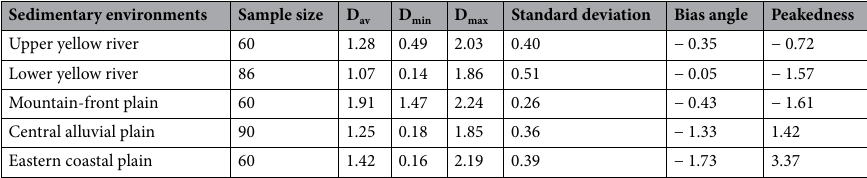
Table 3. Soil fractal characteristics under different sedimentary environments.